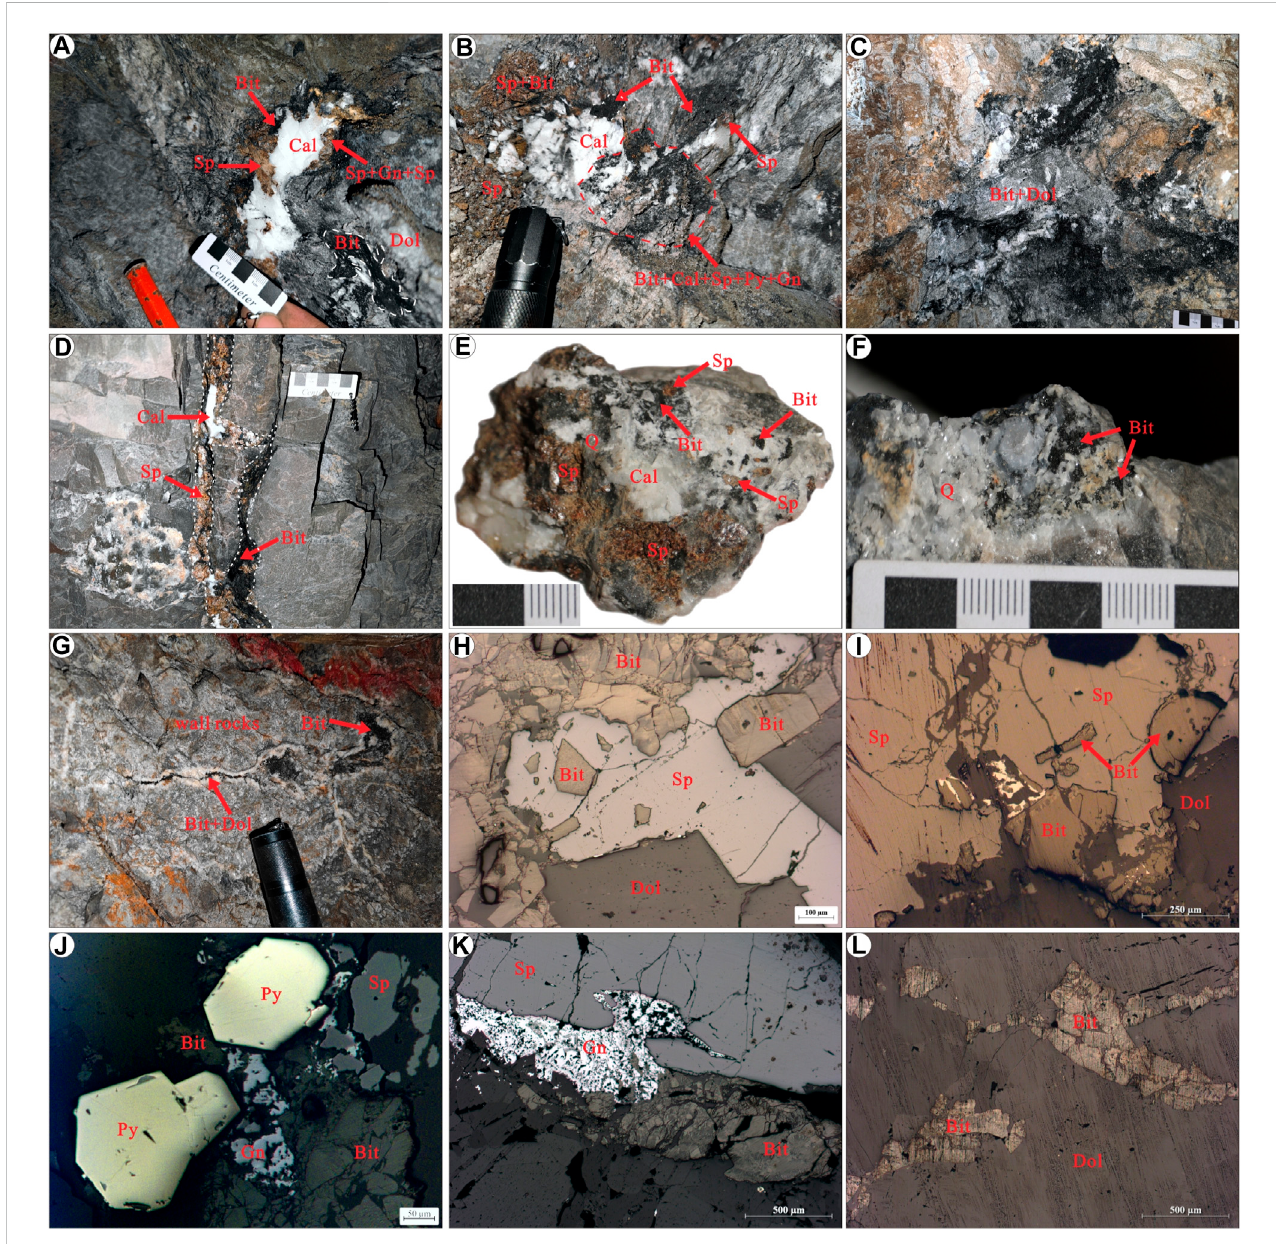
FIGURE 5 PhotosofbitumenandoreintheMaopingdeposit. (A,B) BitumeninDevoniandolomitecloselyassociatedwithsphalerite,asmallamountofgalenaandcoarse- grainedcalcite(NearorebodyI-6,level683 m,Hedongoreblock,Maopingdeposit); (C) Bitumenintheformofclumpsorbindercloselyassociatedwithdolomite(level 846 m,Hedongoreblock,Maopingdeposit); (D) BitumeninCarboniferousdolomite;sphalerite,calciteandbitumeninterminglingand fi llinginalongthe fi ssure(level 818 m, Hexi ore block, Maoping deposit); (E) Ore hand specimen, spherical bitumencoexistswithsphalerite(Near orebody I-6, level 683 m, Hedong ore block, Maoping deposit); (F) Spherical bitumen fi lled between quartz crystals (level 670 m, Hedong ore block, Maoping deposit); (G) Bitumen in dolomite vein (level 670 m, Hedongoreblock,Maopingdeposit); (H) Yellowish-brownbitumenunderthelightre fl ectedbythepolarizingmicroscope,someofitcoatedbysphalerite,andsome are distributed in the edges of sphalerite; (I) Yellowish-brown bitumen at the edge of sphalerite under the light re fl ected by the polarizing microscope; (J) Galena + sphalerite + pyrite + dolomite + bitumen symbiotic association; (K) Galena + sphalerite + dolomite + bitumen symbiotic association; (L) Yellowish-brown bitumen tightly fi lled between dolomite crystals. Cal, calcite; Dol, dolomite; Q, quartz; Sp, sphalerite; Gn, galena; Py, pyrite; Bit,